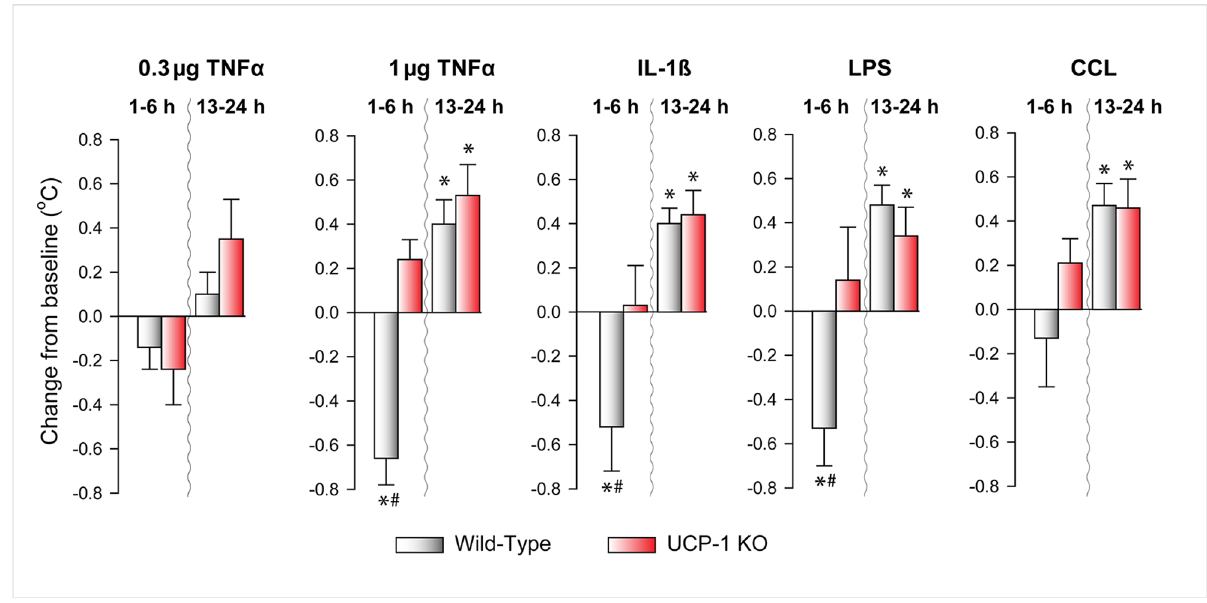
Fig 3. The effects of TNF α ,IL-1 β , LPS and CCL on body temperature in WT and UCP-1 KO mice. Data are expressed as change of average body temperature during the first 6 h and during hours 13–24 after treatments. See legends to Fig 1 for details.